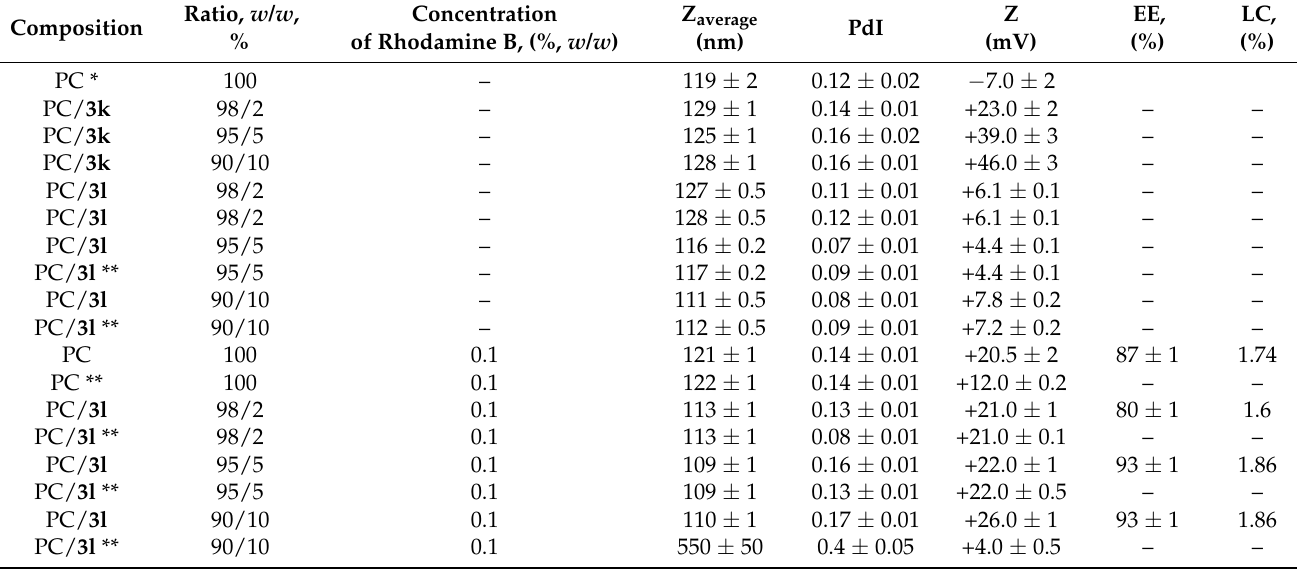
Table 1. Characteristics of Liposomal Systems (25 ◦